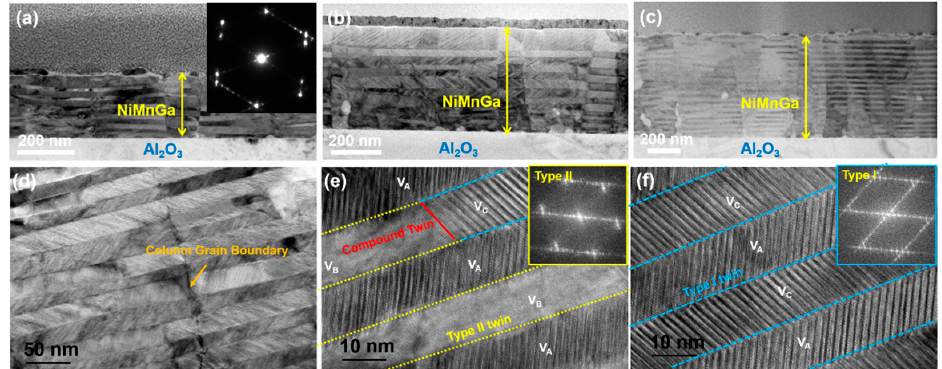
Figure 4. Cross-sectional TEM bright-field images of Ni 51.0 Mn 27.5 Ga 21.5 thin films. ( a ) 200 nm, ( b ) 400 nm, and ( c ) 600 nm. ( d – f ) Detailed analysis of the Ni 51.0 Mn 27.5 Ga 21.5 thin films with a thickness of 600 nm.